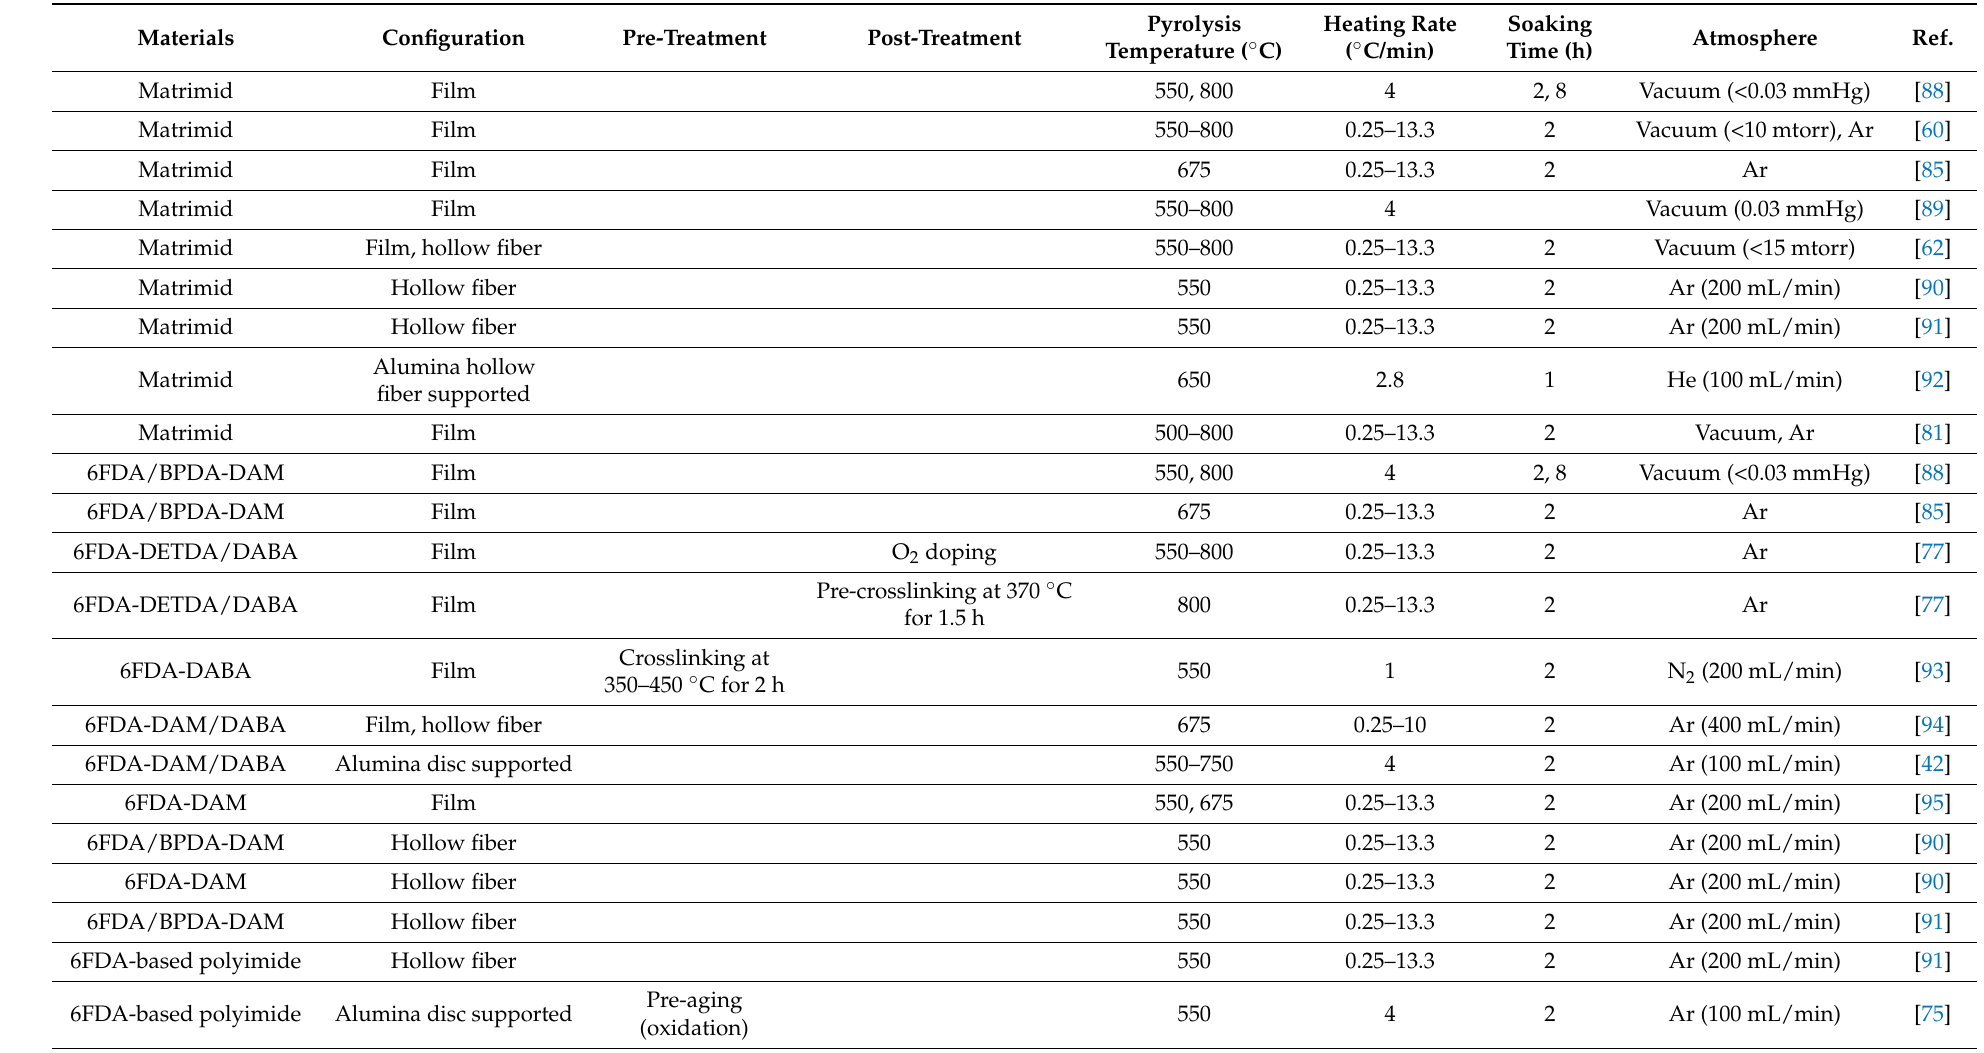
Table 1. Polymer precursors and processes for manufacturing CMS